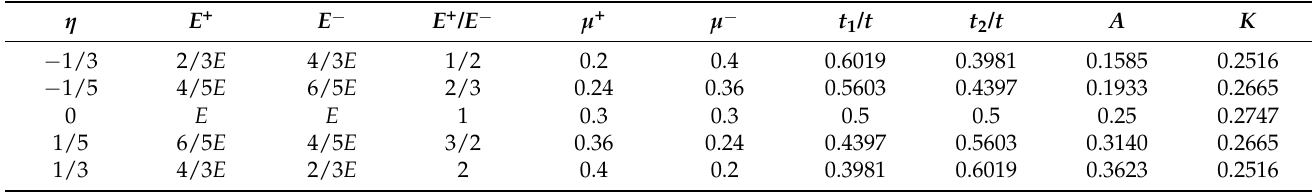
Table 4. The computed values in the relation of load vs. central